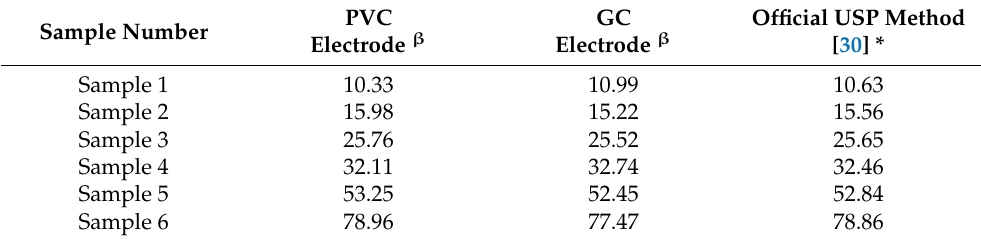
Table 6. Determination of ALN in actual wastewater samples from pharmaceutical plants.